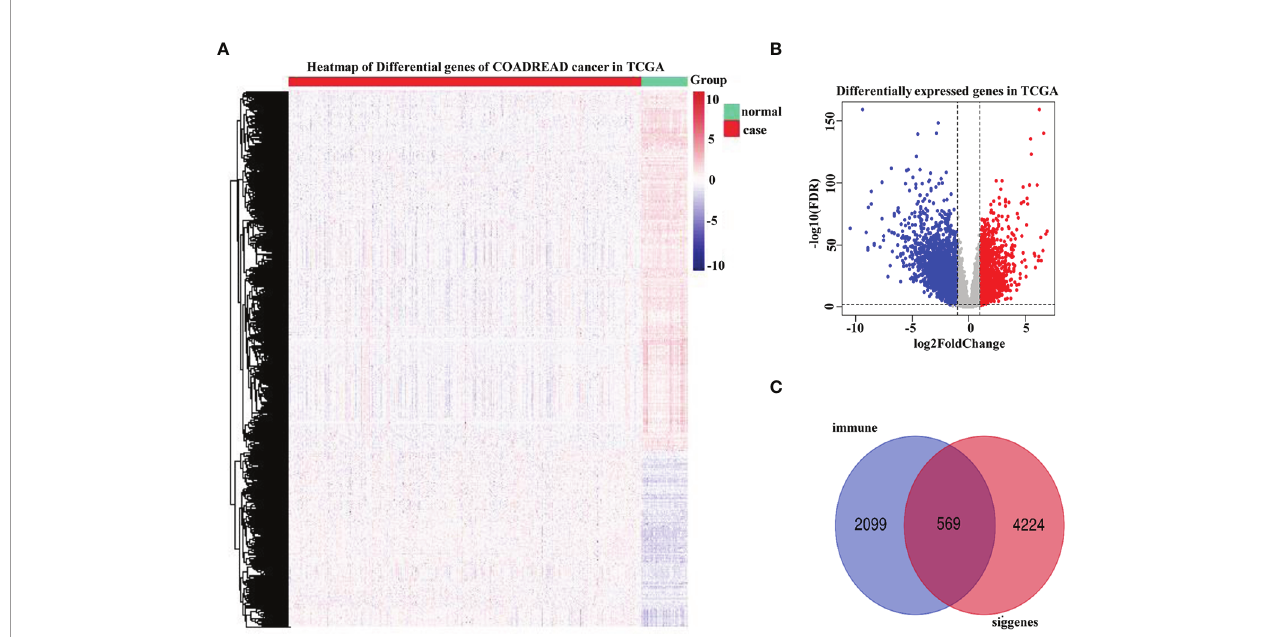
FIGURE 1 | Differentially expressed genes were identi fi ed in The Cancer Genome Atlas (TCGA) analysis. (A) Heatmap of differentially expressed genes in TCGA analysis. (B) Distribution of upregulated and downregulated differentially expressed gene (DEG) in TCGA analysis. (C) Venn diagram depicting common immune- related genes shared by the TCGA dataset, ImmPort database, and InnateDB database.